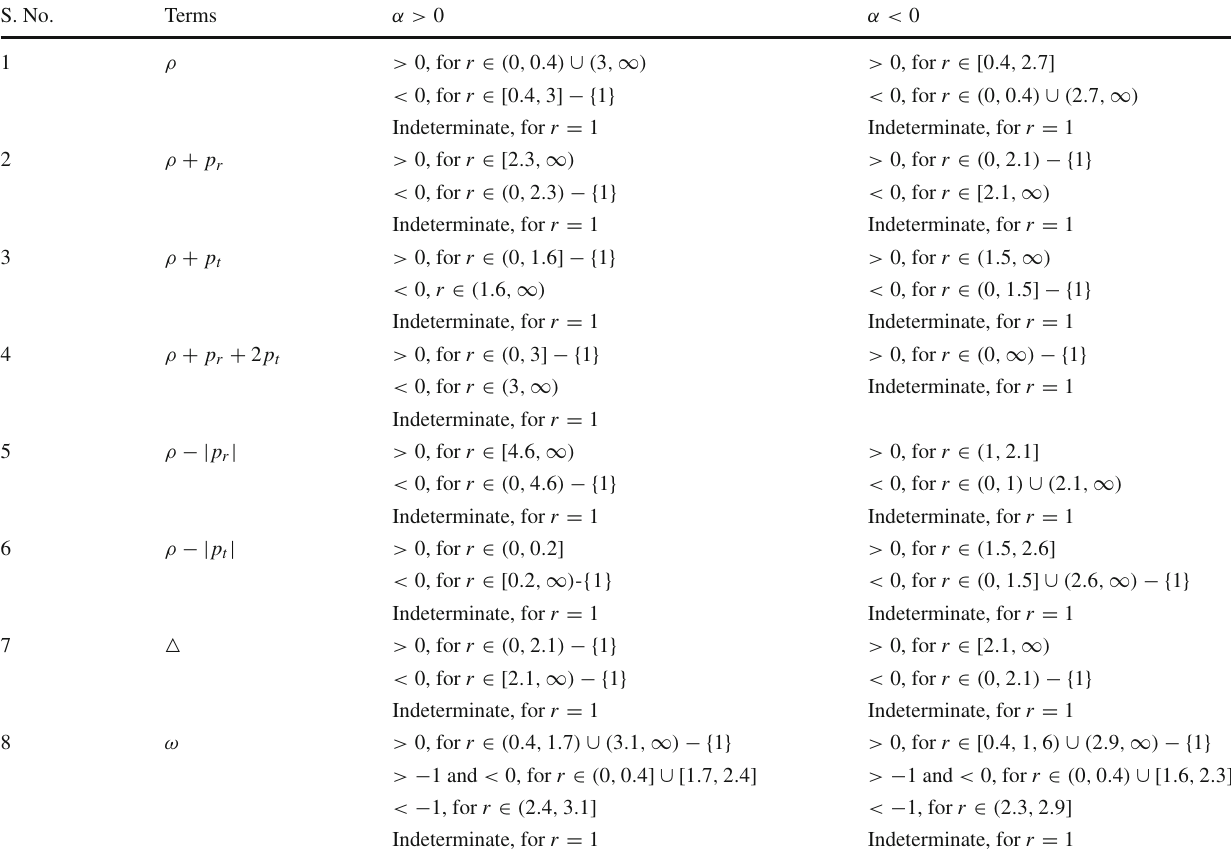
Table 4 Summary of results for φ( r ) = constant with n = 2 S.